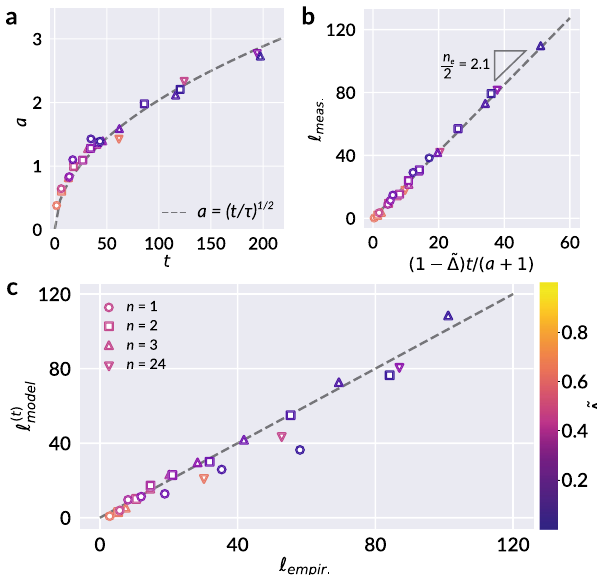
Fig. 4 Model parameters and preliminary comparison to empirical result. a Individual fi ts of the shape parameter a from Eq. (7a) for each facet distribution (scattered points) alongside the best fi t to Eq. (8) (dashed line), corresponding to τ ≈ 24.041. b The measured total crease length ℓ ð 1 (cid:2) ~ Δ Þ t = ð a þ 1 Þ meas. of each segmented sheet plotted against the quantity (scattered points). By Eq. (14), we expect the slope of this plot to correspond to n e /2, or half the average number of facets per facet. A best fi t line reveals n ≈ 2.1, or n ≈ 4.2 (dashed line). c With the results of e /2 e (cid:3) ‘ ð t ; ~ Δ Þ as given by the a and b , we can make a comparison of ‘ ð t Þ model derived relation Eq. (14), with the experimental model ‘ empir : (cid:3) ‘ ð n ; ~ Δ Þ of Eq. (11). The parameters of Eq. (11) are set to c 1 = 52 (normalized by 100 mm sheet size) and c 2 = 0.1, comparable to the best fi t values reported in Gottesman et al. 16 : c 1 = 5200 mm, c 2 = 0.063. A 1:1 reference line (dashed) is provided as a guide to the eye, and shows good agreement between the two models. Marker colors in all panels correspond to different values of ~ Δ , as indicated by the